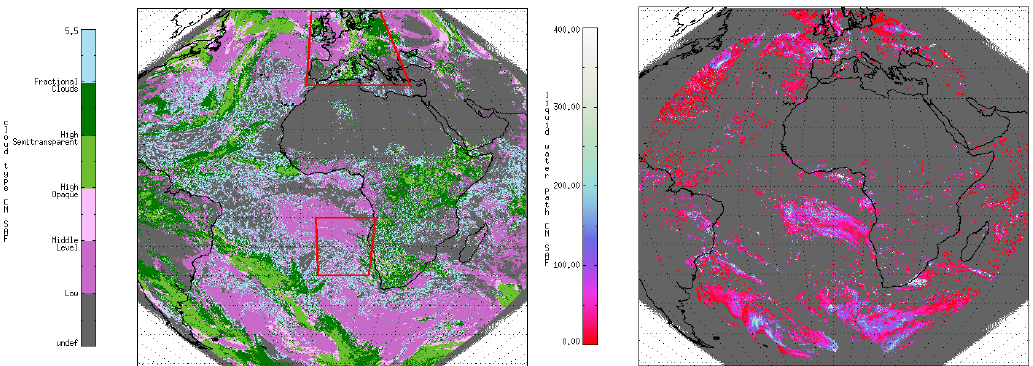
Fig. 1. Left: cloud type for liquid and ice pixel on full SEVIRI disc with horizontal resolution 3 km × 3 km at subsatellite point, the red squares depict the two regions of interest, right: liquid water path; both at 11:45 UTC, 10 October 2009.